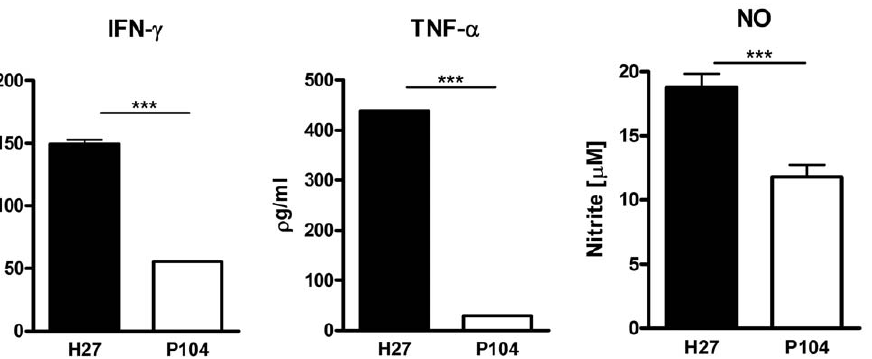
Figure 7. Production of pro-inflammatory mediators in culture of cells obtained from lungs of C57BL/6 WT mice infected with M. avium H27 or P104 strains. Lung cells were isolated on day 30 after i/t infection of mice and cultured in 96 well-plates, 5 6 10 4 cells/well. Culture supernatants were collected after 48 h incubation and concentrations of IFN- c and TNF- a were measured by sandwich ELISA. Nitric oxide production was measured by Griess reaction. The data were obtained in two independent experiments. Asterisks represent statistical significance (***p ,